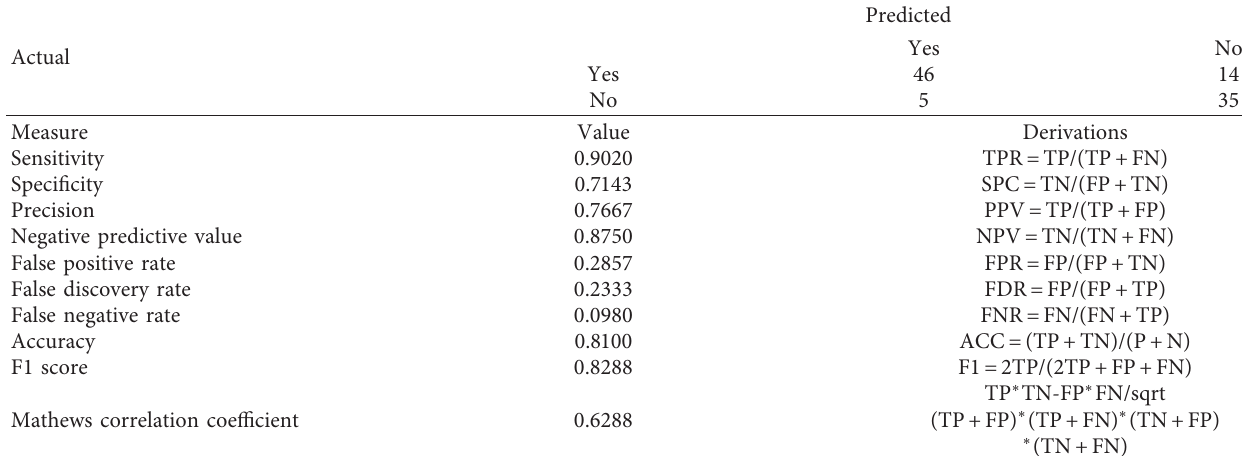
Table 2: Confusion